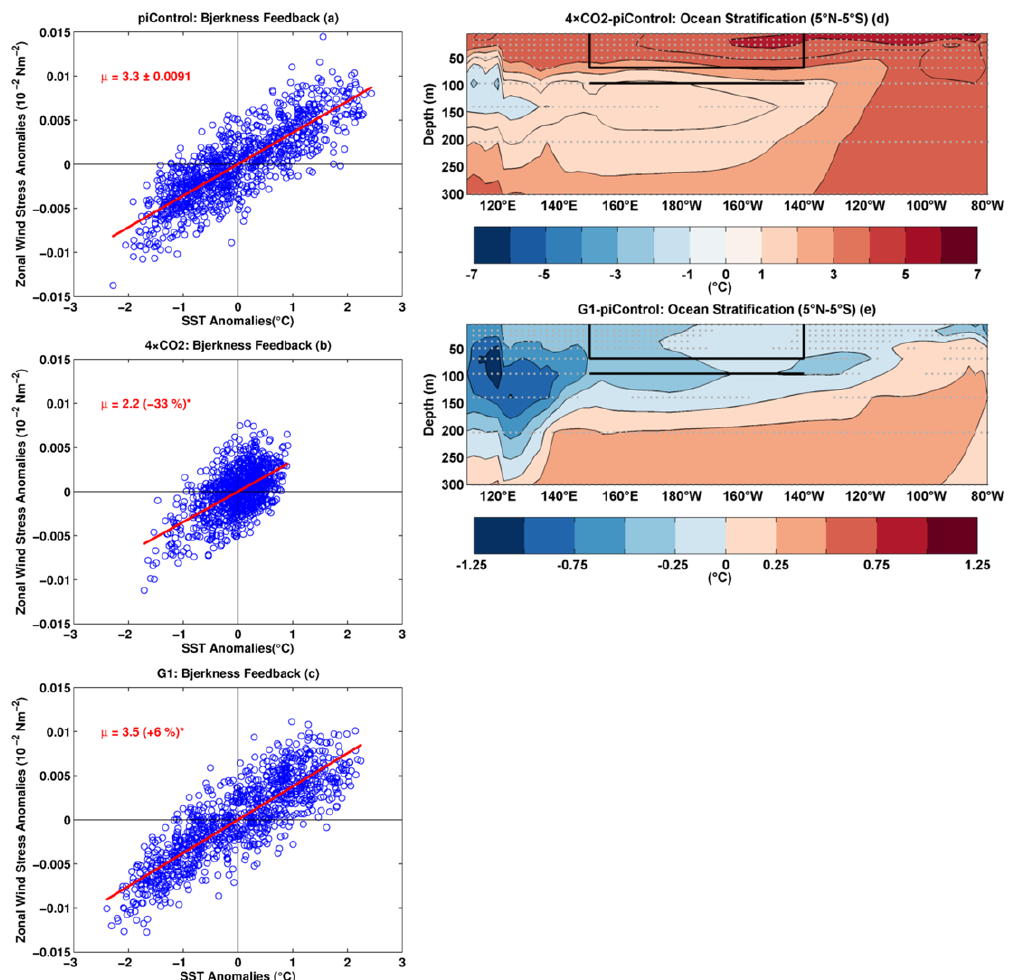
Figure 15. BJ feedback ( µ ; 10 − 2 Nm − 2 / ◦ C) for (a) piControl, (b) 4 × CO 2 , and (c) G1. The value with the ± sign indicatesSD of µ after 10000 bootstrap realizations. An asterisk indicates statistical significance at 99%cl. Mean change in ocean temperature: (d) 4 × CO 2 - piControl and (e) G1-piControl. The black box shows the area-averaging region for upper-ocean temperature, and the black line shows the lower layer used for calculation of stratification as a difference in upper and lower layer. Stipples indicate grid points with statistical significance at 99%cl using a non-parametric Wilcoxon rank-sum